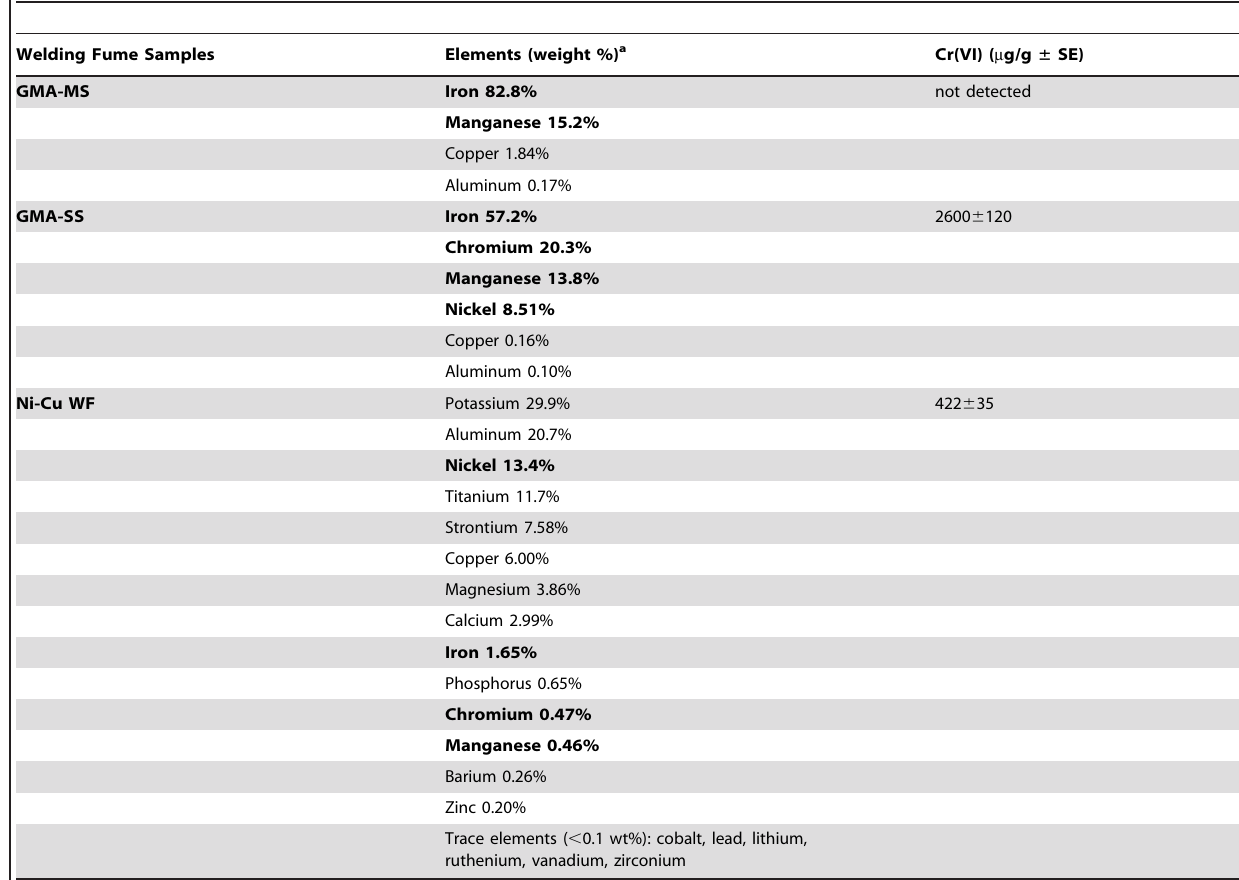
Table 1. Metal content analysis of the welding